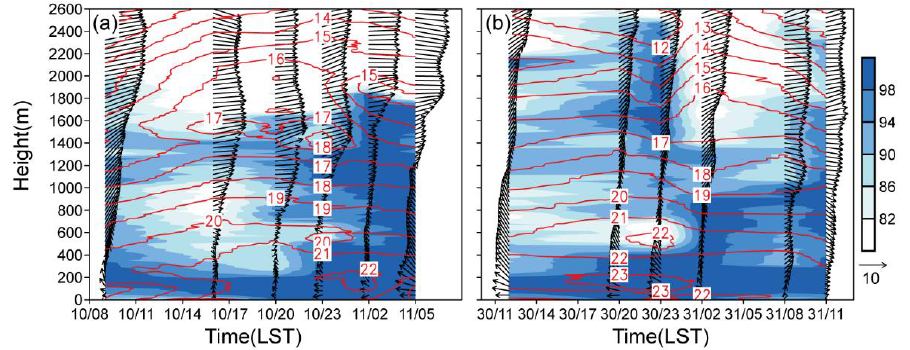
Figure 9. Soundings at the coastal site during the two sea-fog cases. The red line is air temperature, the shading is relative humidity, and the vector is horizontal wind. ( a ) Case 1. ( b ) Case 2. Scales for RH (%) and wind (m s − 1 ) are at right.